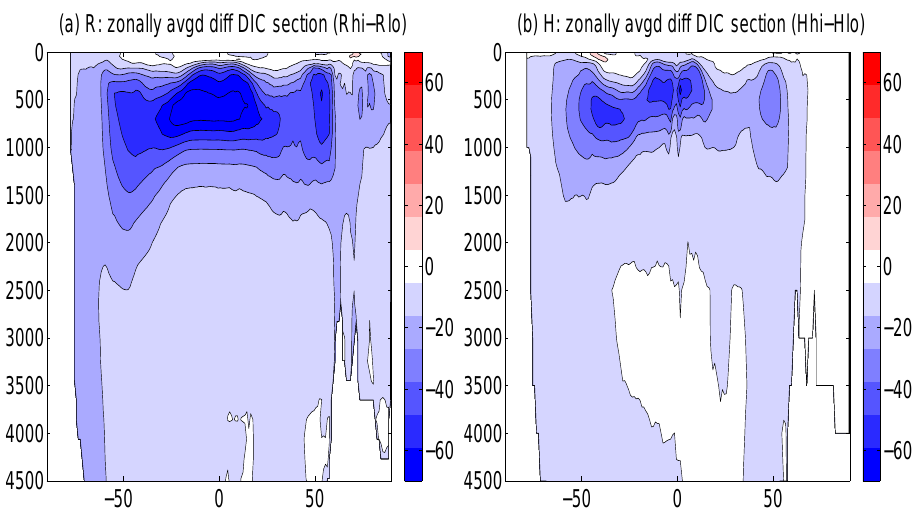
Fig. 12. Differences in the DIC zonally averaged vertical sections between same model runs with varying remineralization rates. In both models, as we increase remineralization rates, the carbocline gradient at mesopelagic depths decreases and therefore more DIC can reach the surface through vertical mixing, which ex- plains the increased DIC distributions there. This is mostly evident north of 50 ◦ S (i.e. north of the 495 SAF). The changes in partial pressure of CO 2 at the surface of the ocean (pCO 2 ) mirror the changes